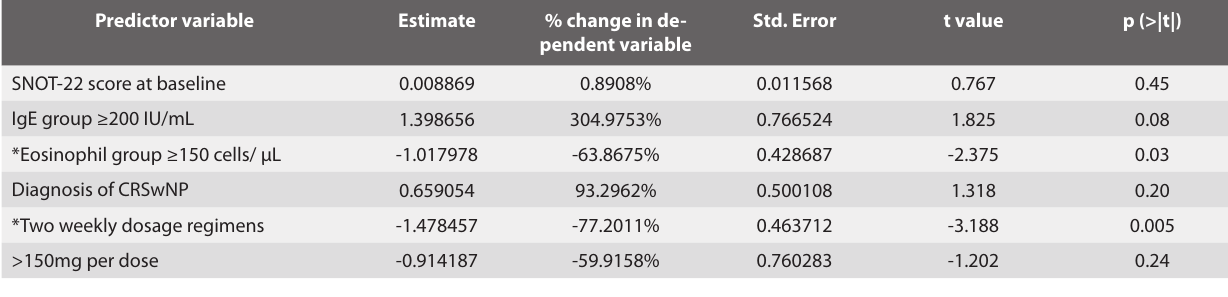
Table 3. Summary of output of linear model, with starred variables being calculated as